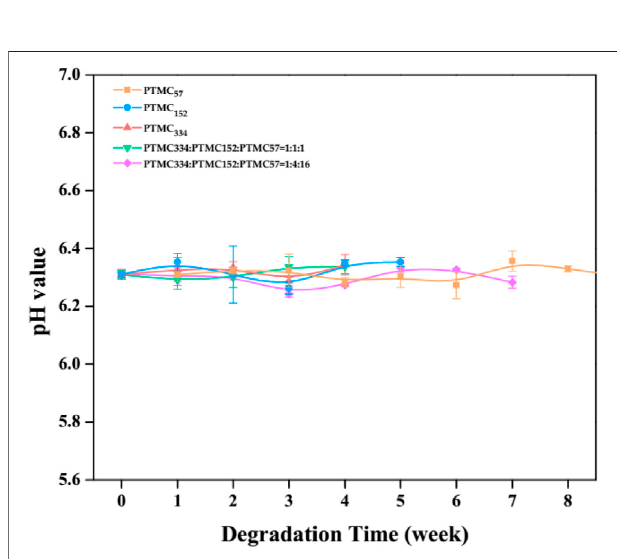
FIGURE4| ThepHoflipasesolutionsofPTMC fi lmsandtheternaryself- blending fi lms during enzymatic degradation.